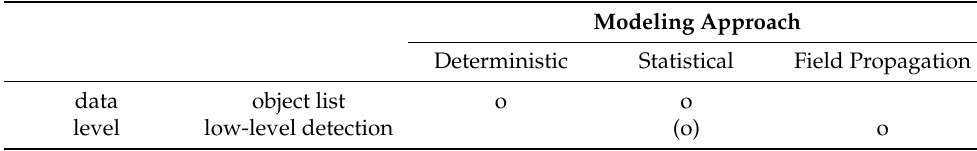
Table 1. Classification of sensor modelling methods according to